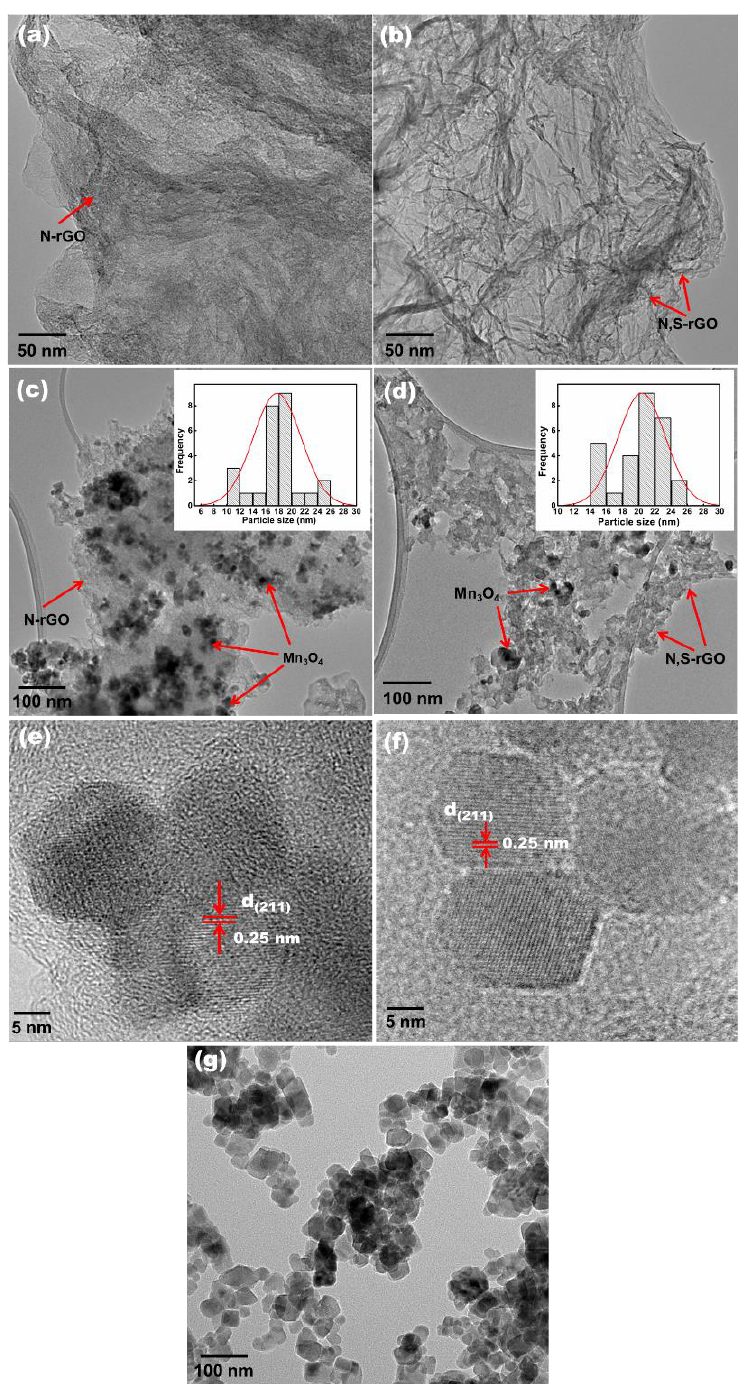
Figure 4. TEM images of ( a ) N-rGO aerogel, ( b ) N,S-rGO aerogel, ( c ) Mn 3 O 4 /N-rGO aerogel (inset: particle-size distribution), ( d ) Mn 3 O 4 /N,S-rGO aerogel (inset: particle-size distribution), and ( g ) Mn 3 O 4 nanoparticles and HRTEM images of ( e ) Mn 3 O 4 /N-rGO aerogel and ( f ) Mn 3 O 4 /N,S-rGO aerogel.